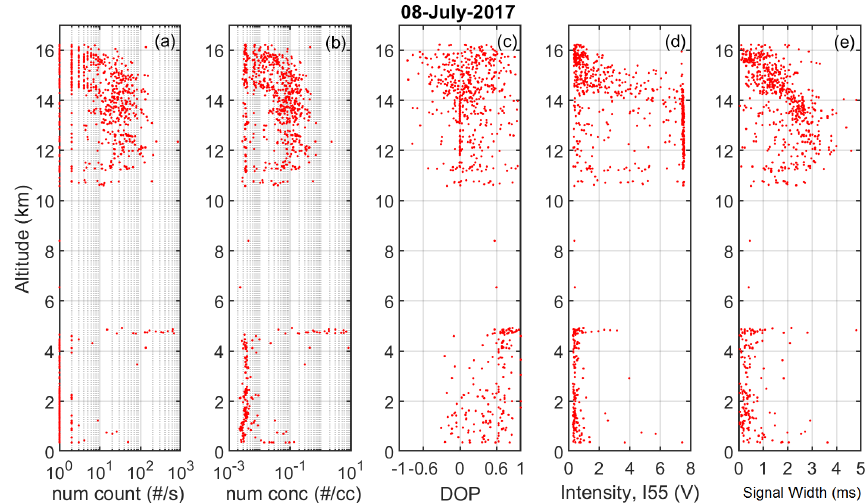
Figure 4. CPS measurements collected from the second pilot campaign (8 July 2017) showing (a) cloud particle number count (corrected) per second, (b) cloud particle number concentration per cubic centimetre, (c) degree of polarization of a cloud particle (DOP), (d) the intensity of light scattered at 55 ◦ angle in volts, and (e) the particle signal width in milliseconds.